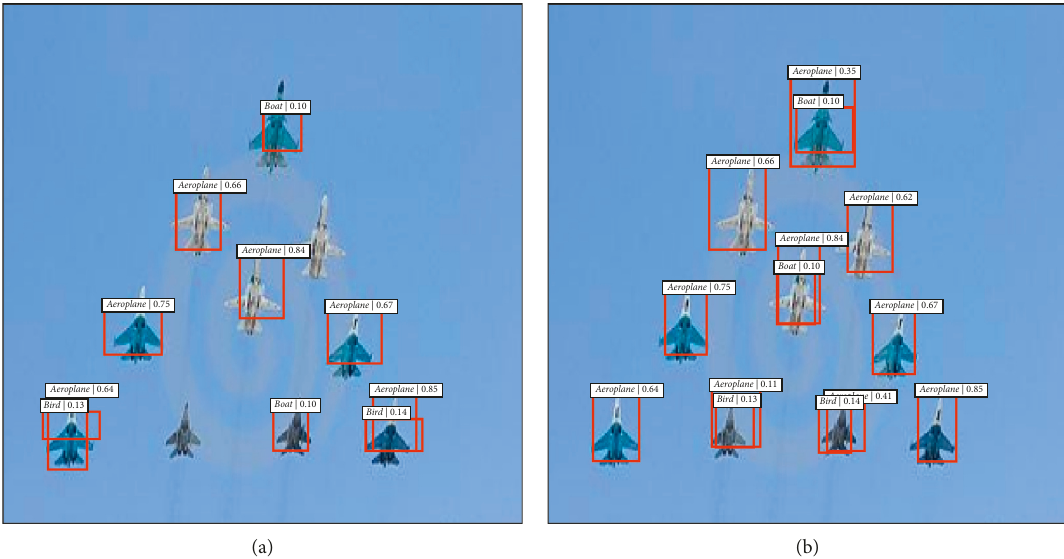
Figure 8: Comparison of feature detection results. (a) SSD. (b)